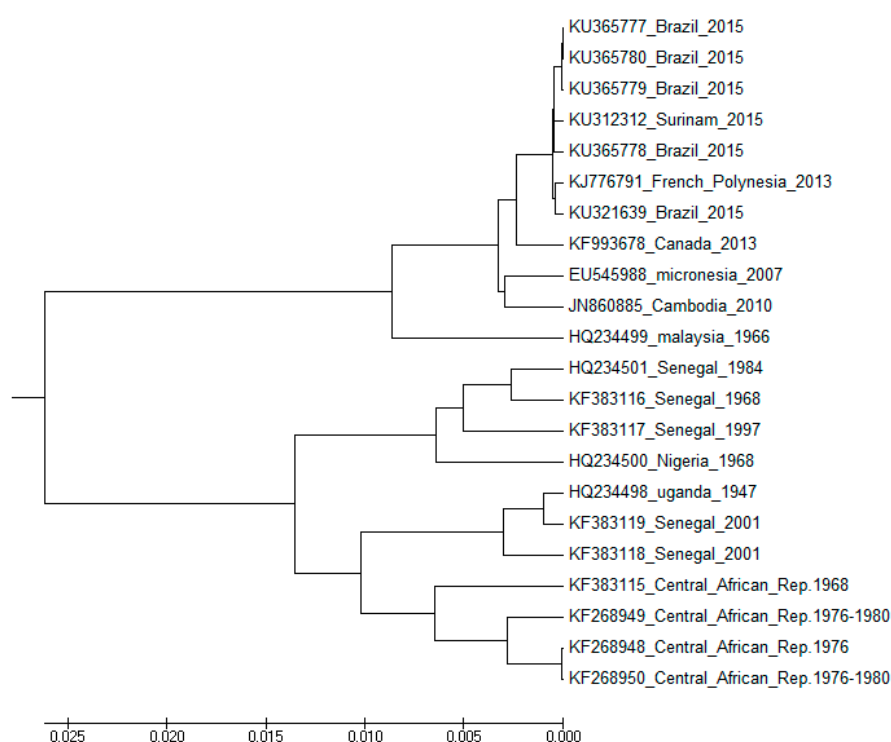
Figure 2. Phylogenetic tree of 22 ZIKV genome sequences [17]. Each sequence is identified with its accession number, country, and year of collection. The horizontal axis shows relative amount of character change between different sequences. Reproduced with permission from Bentham Science Publishers, www.benthamscience.com. Table 2. The pre-epidemics period of the Zika virus after its detection in 1947. A. africanus : Aedes africanus ; ZIKV: Zika